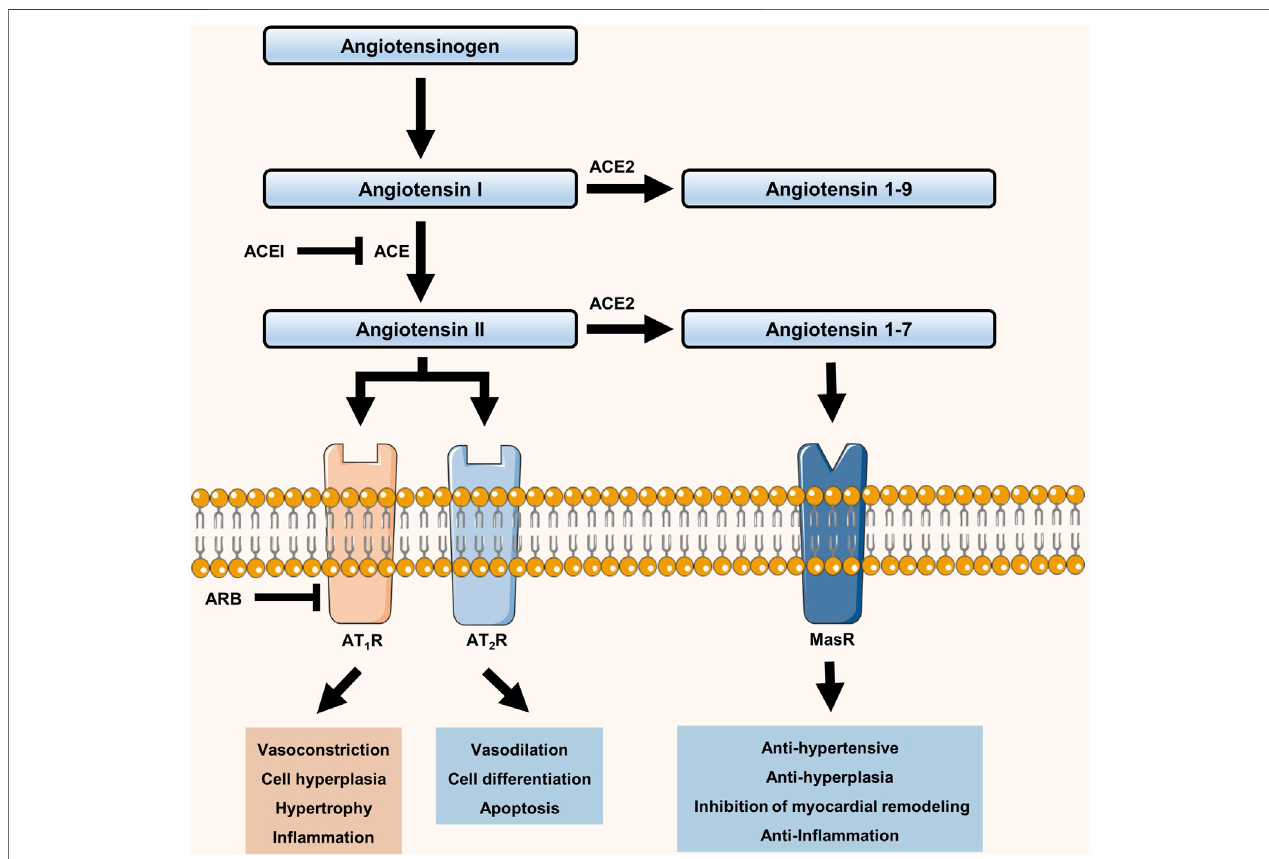
FIGURE 1 | Schematic diagram of the renin – angiotensin – aldosterone system (RAAS).